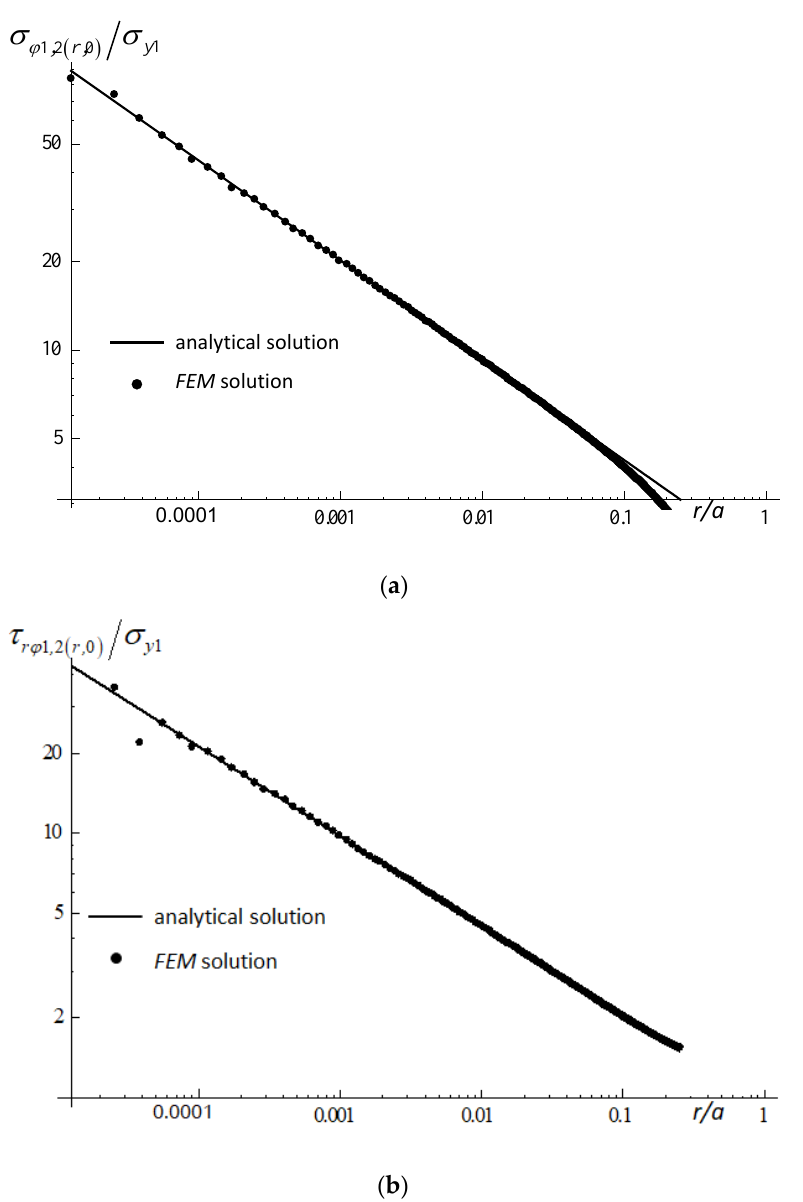
Figure 11. Comparison of selected stress distributions (pure shear loading) obtained by the FEM (points) and according to the analytical Formula (11) using the factors from Table 6, (continuous lines), ( a ) hoop stress, ( b ) tangential stress, ( φ = 0°, 2 ψ = 30 ° , Г = 0.5).